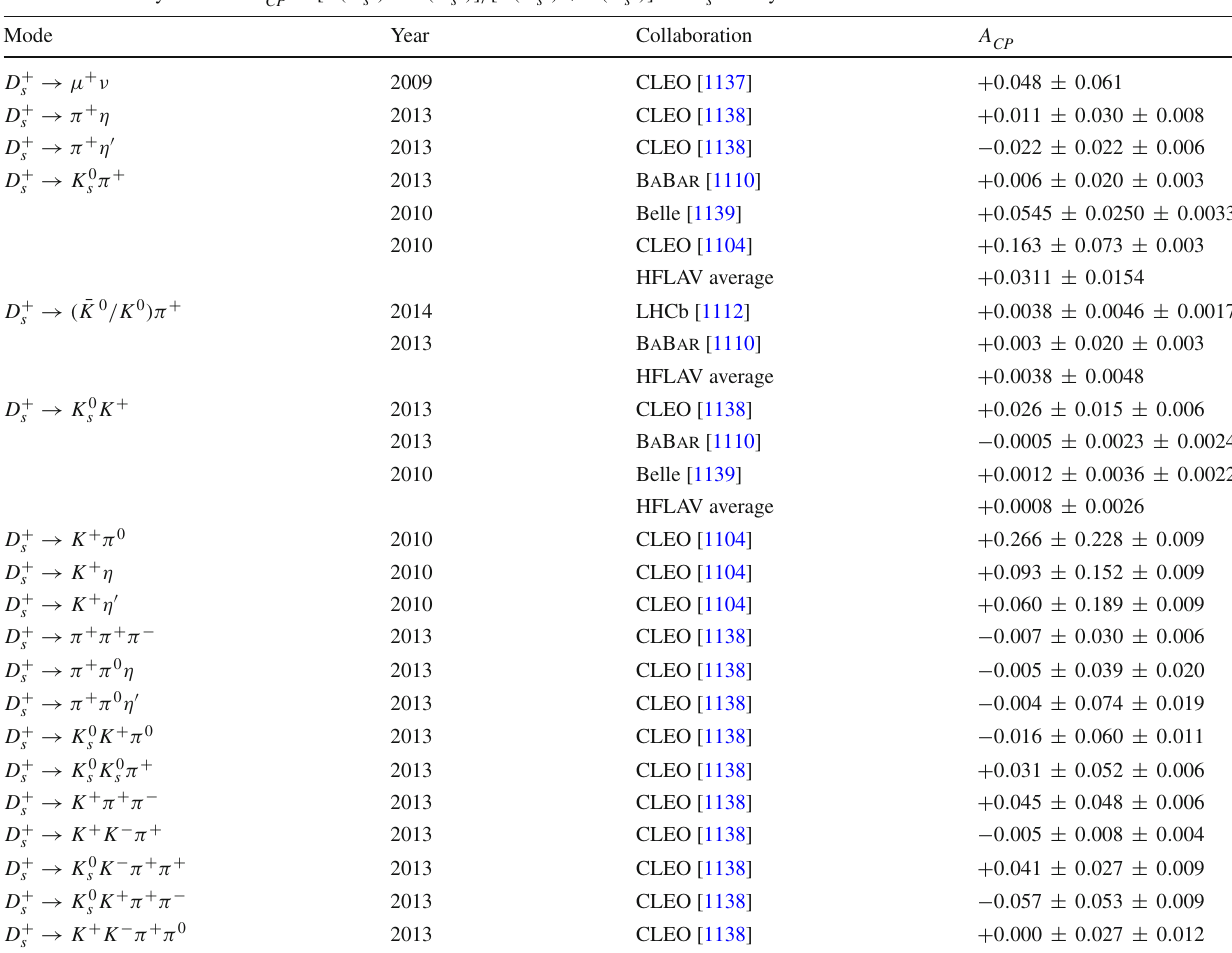
Table 268 CP asymmetries A